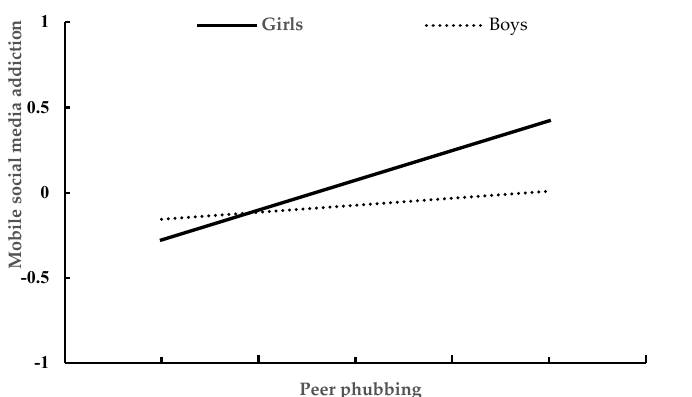
Figure 2. The relationship between peer phubbing and mobile social media addiction in girls and boys.